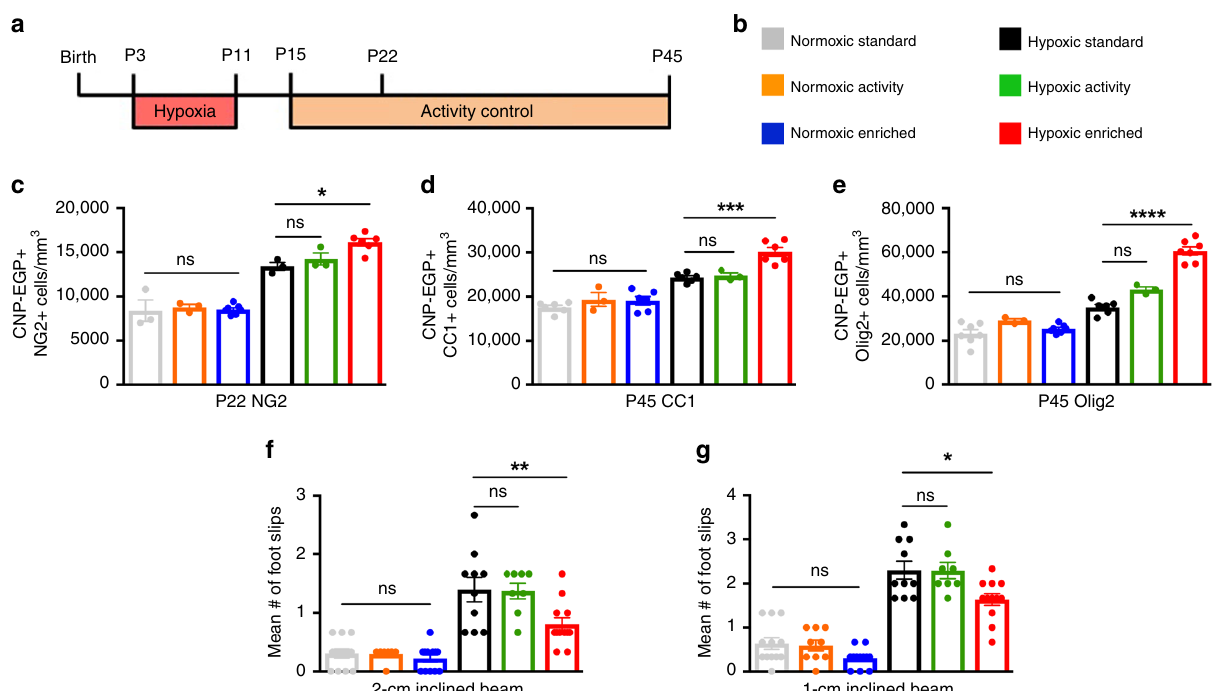
Fig. 4 Locomotor activity alone had no effects on OL maturation and did not improve functional recovery after perinatal brain injury. a Experimental paradigm. Activity control consisted of access to a running wheel. b Experimental groups. c Quanti fi cation of total EGFP + NG2 + OPCs at P22 (* p = 0.015) (NX, n = 3; NX Activity (NX-A), n = 3; NX-EE, n = 7; HX, n = 3; HX Activity (HX-A), n = 3; HX-EE, n = 6). d Quanti fi cation of total EGFP + CC1 + OLs